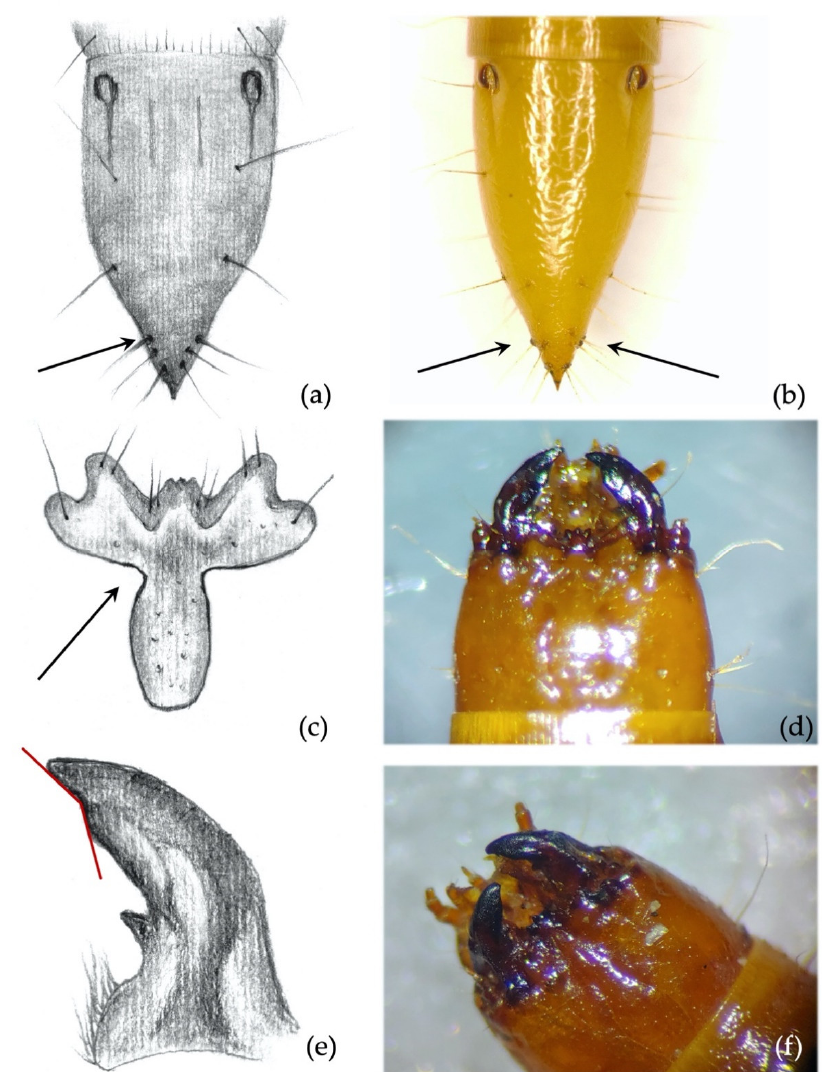
Figure 4. Agriotes ustulatus (Schäller 1783). Discriminating characters: ( a , b ) 9th abdominal segment with dark elevated tubercles around setae; ( c ) details of the frontoclypeus forming an angle >90° in about 99.5% of the specimens; ( d ) view of the head with frontoclypeus; ( e ) details of the right mandible with subapical tooth forming an angle clearly >90°; ( f ) view of the head with mandibles. Secondary